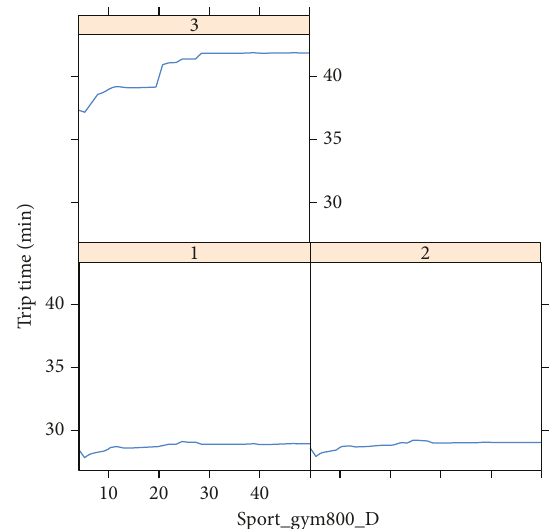
Figure 9: Interactive effects between sport/gyms density and the location of the boarding station on trip time (H-statistic �